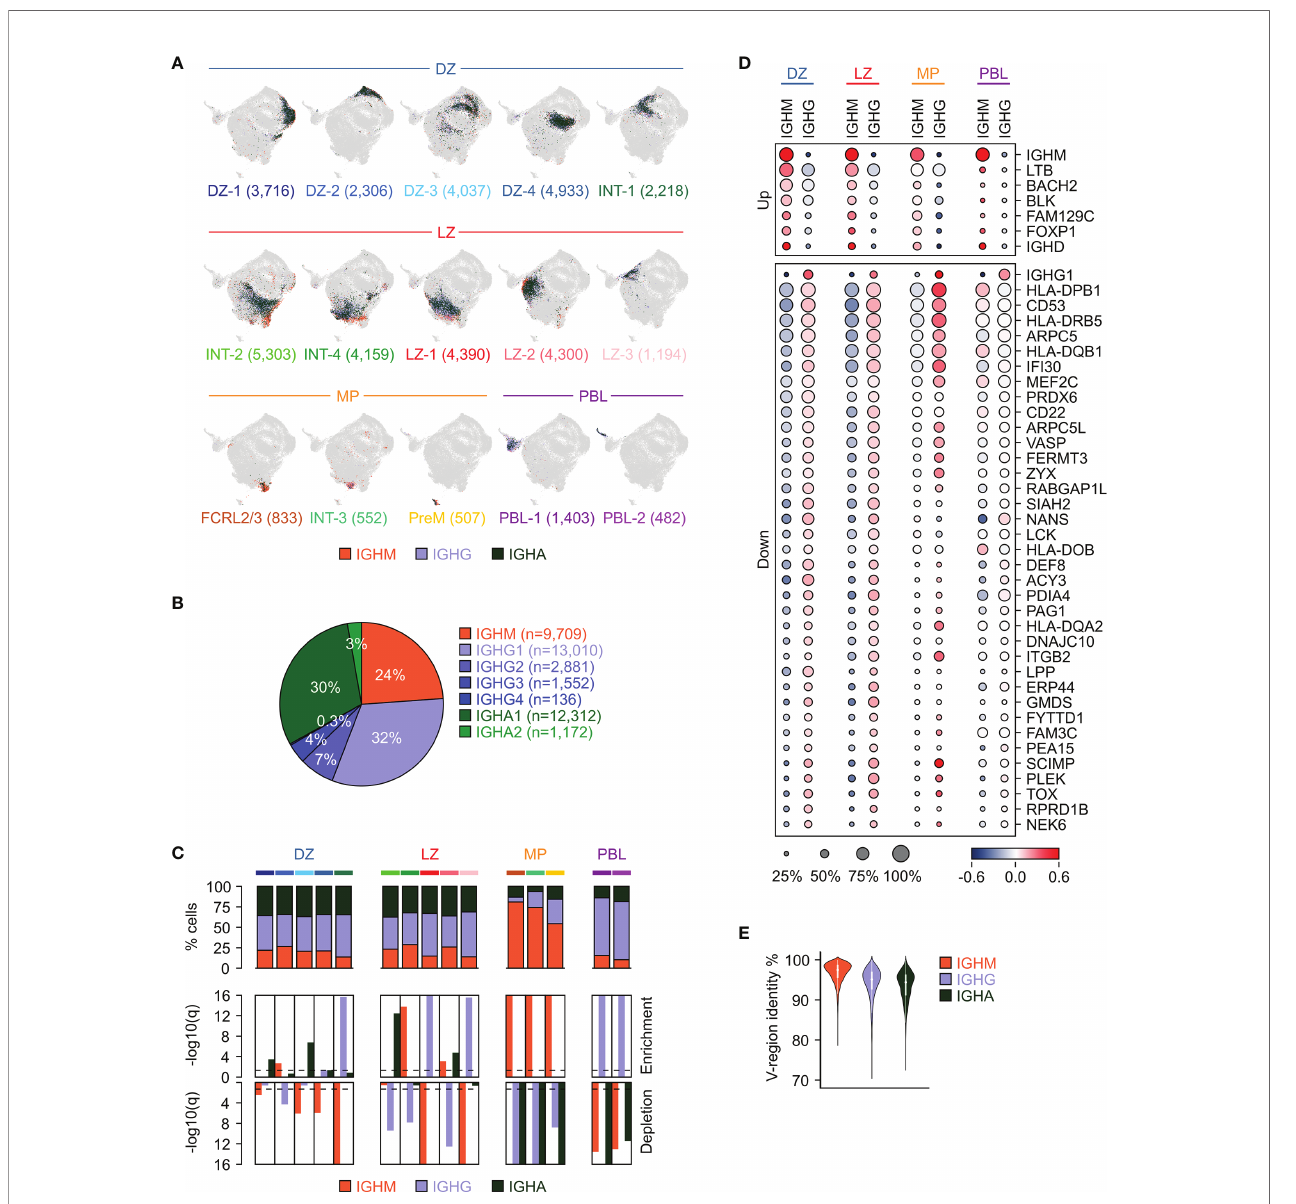
FIGURE 3 | Immunoglobulin isotype distribution in GC B cell subpopulations. (A) UMAP projection in which cells in each cluster are labeled based on the immunoglobulin isotype class type: IGHM (orange), IGHG (light blue), or IGHA (dark green). The number of cells belonging to each cluster is provided in parenthesis. (B) Distribution of GC B cells based on their expression of isotype subclasses. (C) Stacked bar plots showing for each GC cluster the percentage of cells within the immunoglobulin isotype classes (top panel). Enrichment (middle panel) and depletion (bottom panel) analyses of the immunoglobulin isotype classes in the GC clusters (hypergeometric test with Benjamini-Hochberg correction, q < 0.05). (D) Differential gene expression analysis between unswitched (IGHM) and switched (IGHG) cells in each of the major GC subgroups (DZ, LZ, MP and PBL). The size of the dot indicates the percentage of cells with detectable expression, and the color re fl ects the relative gene expression shown as the z-scored average (log2) normalized expression within a group. (E) Violin plot showing the distribution of the V-region identity in cells expressing unswitched (IGHM) or switched (IGHG and IGHA) immunoglobulin isotype